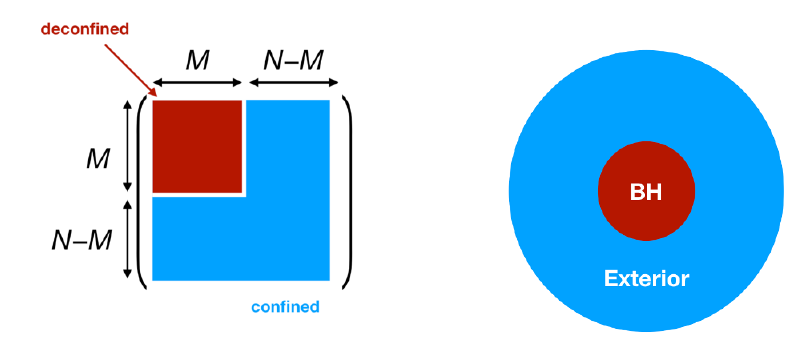
Figure 4 . A natural dual gravity interpretation of partial decon(cid:12)nement.